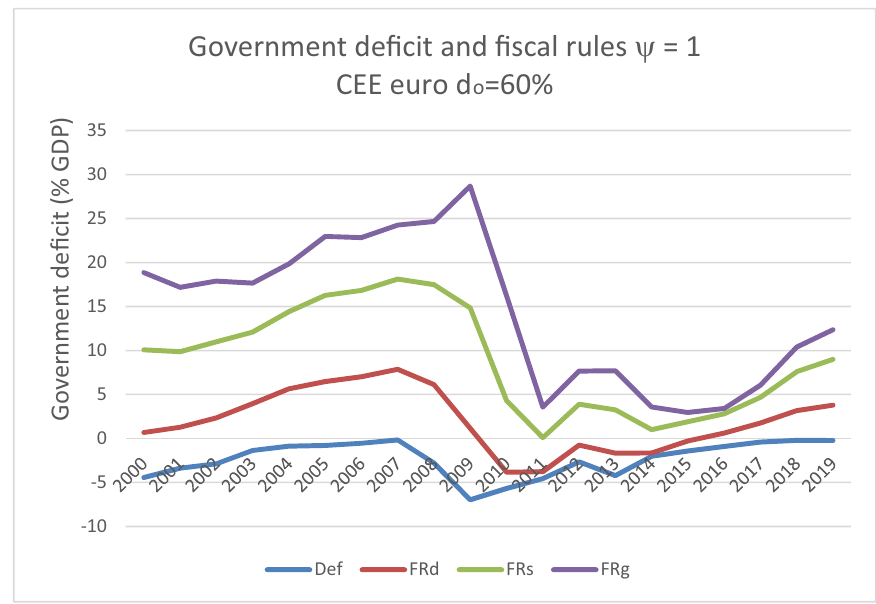
Figure 1.6: CEE € countries government de fi cit ψ = 1 ( Source: Own elaboration from data on Table 1 )